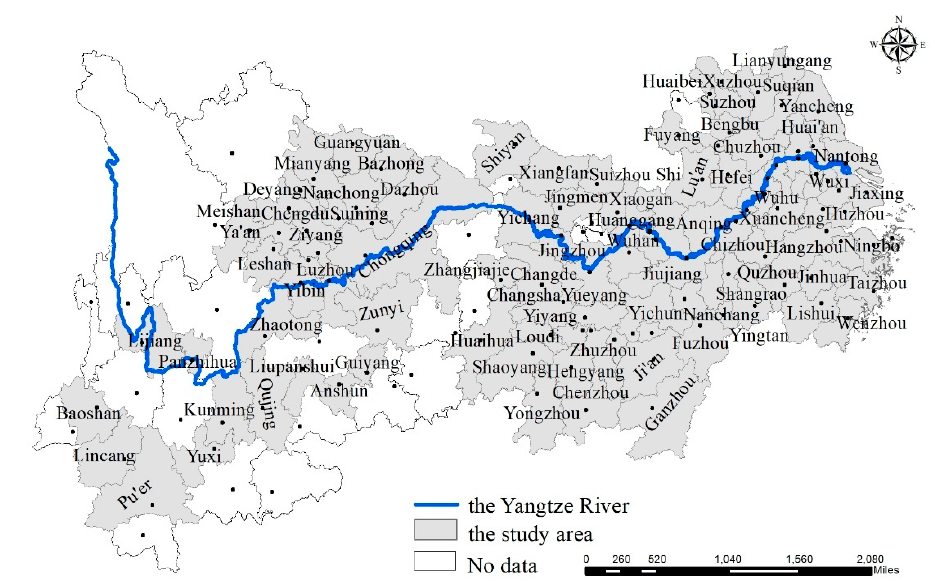
Figure 1. Study Figure 1. Study area.